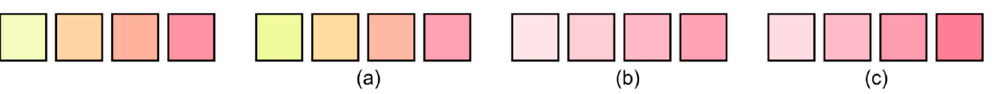
Figure 7. The OpenStreetMap road network color scheme.